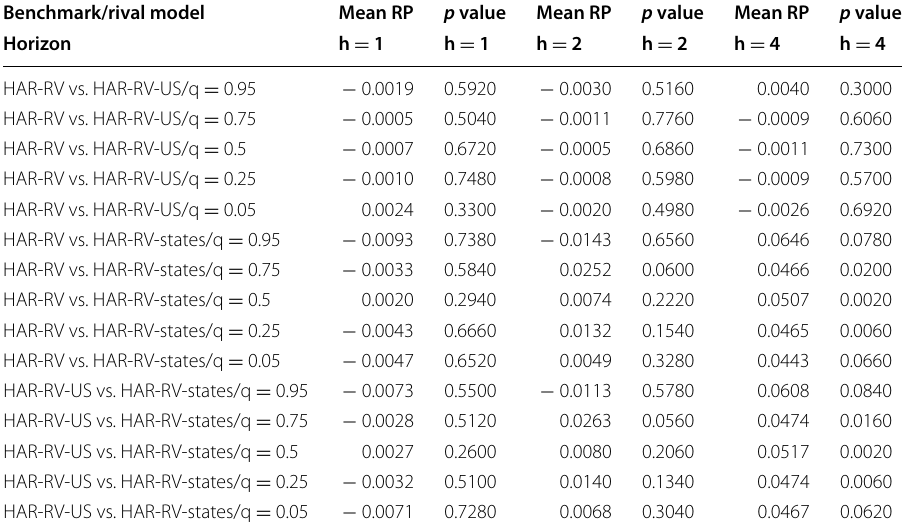
The models are estimated 500 times on bootstrapped data sampled without replacement. For every estimation, the relative- performance statistic, RP , statistic is computed as RP = 1